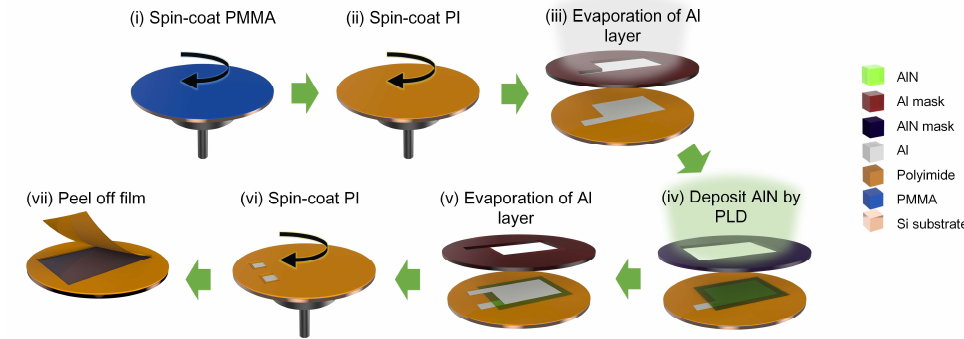
Figure 1. Fabrication procedure of the developed AlN-PNG.